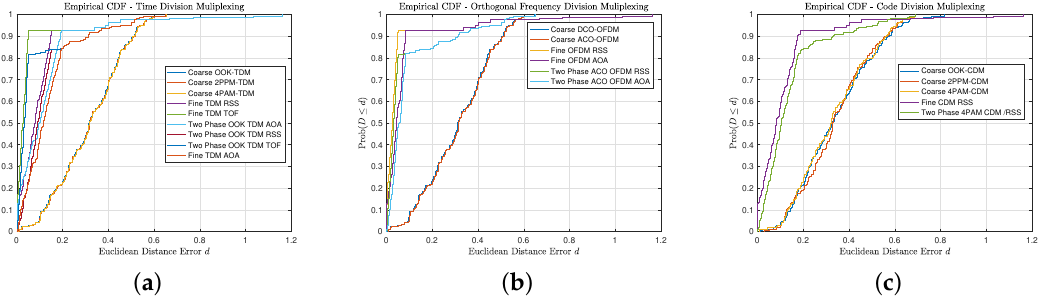
Figure 18. Model Description: ( a ) Two-Phase Precision with TDM Multiplexing; ( b ) Two-Phase Precision with OFDM Multiplexing; ( c ) Two-Phase Precision with CDM